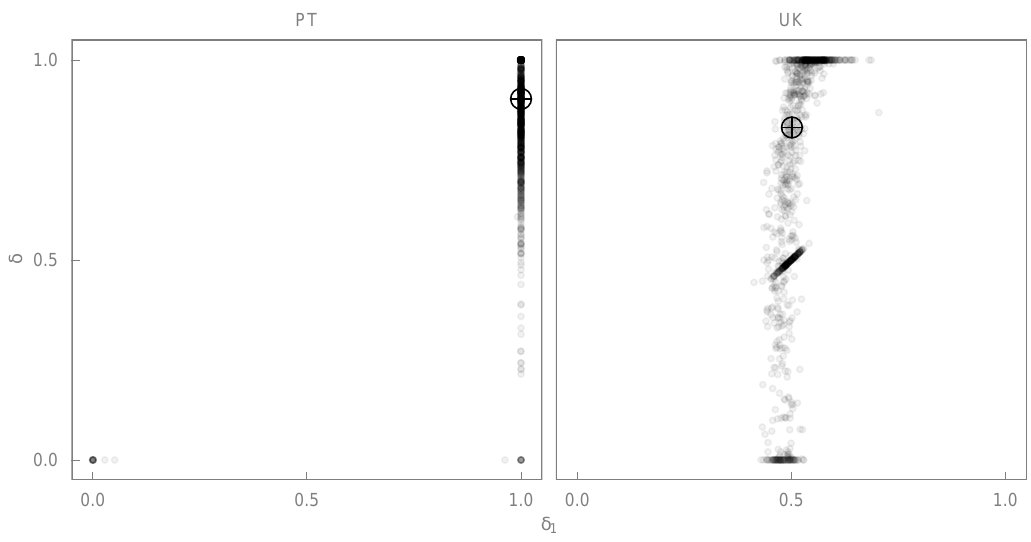
Figure 8. Bootstrap resampling distribution for ˆ δ and ˆ δ 1 for resampled CES models that reject the CSP, include energy, use quality-adjusted factors of production, and employ the ( kl ) e nesting. Parameter estimates from the original data ( ˆ δ and ˆ δ 1 ) are shown as crosshairs ( ⊕ ). Each dot ( • ) represents parameter estimates from one of the 1000 resampled data sets. 95% transparency is used so that twenty coincident dots will appear